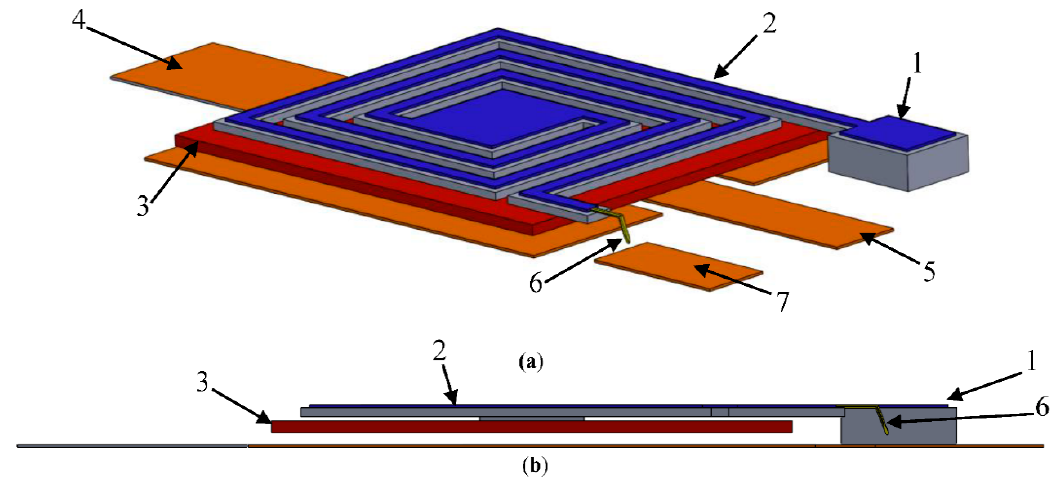
Figure 2. ( a ) Shows the 3D View of the CAD model of the sensor structure with anchor point (1), PolySi beam and metal layer (2), seismic mass (3), self-test pad (4), actuator pad (5), tunneling tip (6) and tunneling pad (7). ( b ) Shows the model in the side